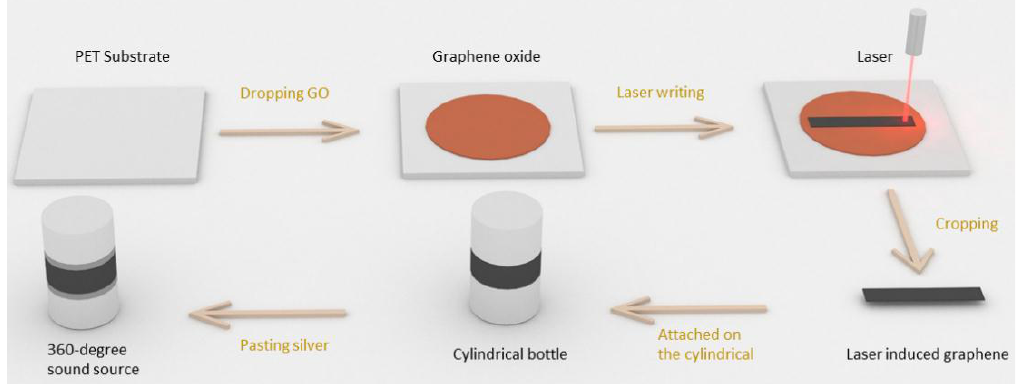
Figure 1. Fabrication process of the 360-degree thermal sound source.